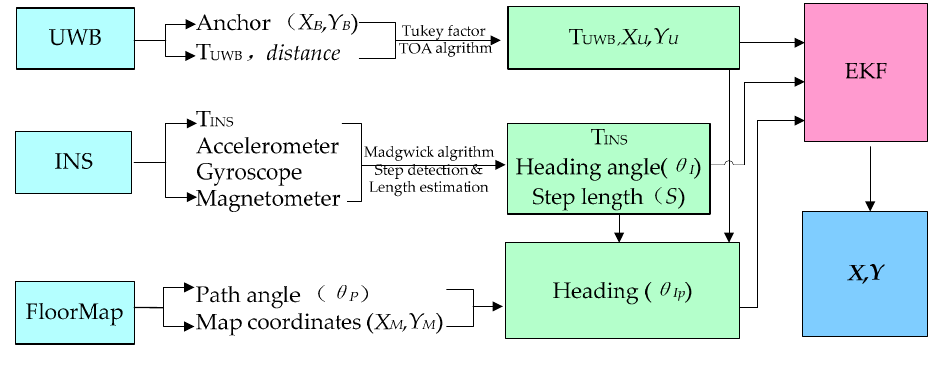
Figure 2. The overall flowchart.